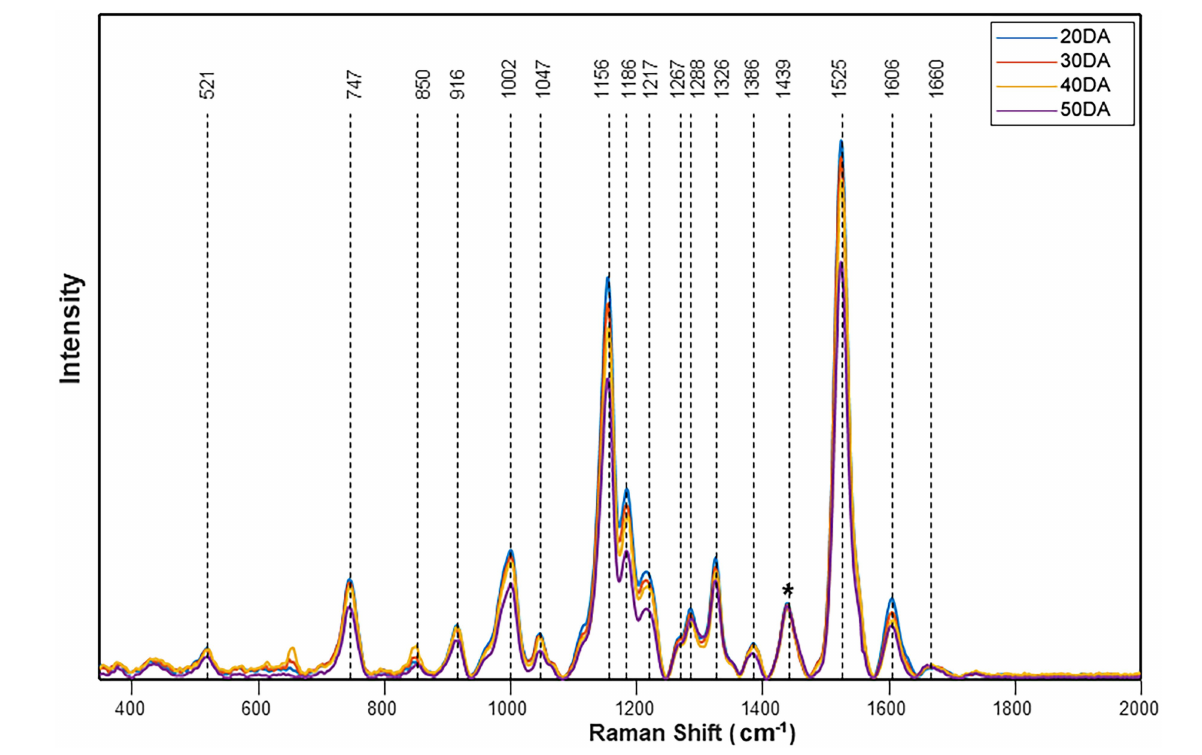
FIGURE 1 | Raman spectra obtained from the surface of the watermelon fruit Fascination cultivar. The stacked spectra represent an average of 20DA = 43, 30DA = 42, 40DA = 42, and 50DA = 24. The spectra were normalized at 1,439 cm − 1 [Marked with an asterisk (*)].